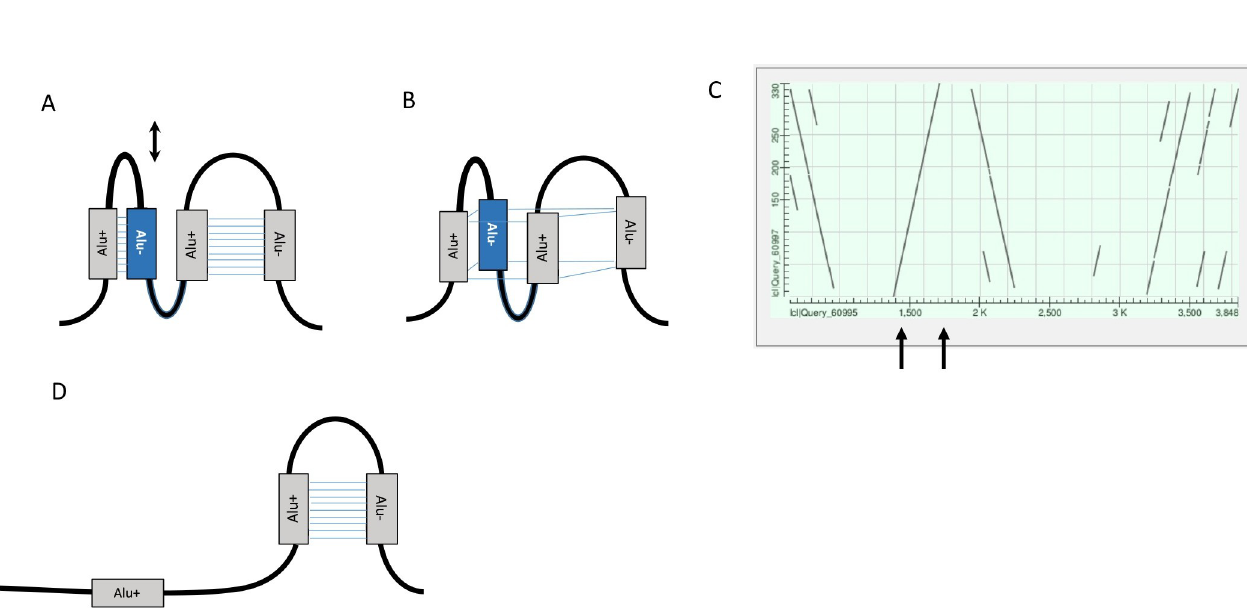
Fig 8. A schematic of the secondary structure of intron 3 in the RBMX2 gene. Altogether four Alu elements can be found within this intron. The gray boxes represent reference like Alu elements while the blue Alu box represents the Alu element with the 330bp deletion. The sense and antisense strands are marked with a plus and minus sign, respectively. ( a ) The pre-mRNA secondary loops are shown for the Alu elements of opposite orientation. ( b ) A DNA Alu G- quadruplex structure is shown as described by Larsen et al 2018(22). ( c ) The full extent of the homologies between the Alu elements and the RBMX2 gene intron 3 sequence are shown in this dotplot. The black arrows indicate the start and end positions of the Alu element with the 330bp deletion.